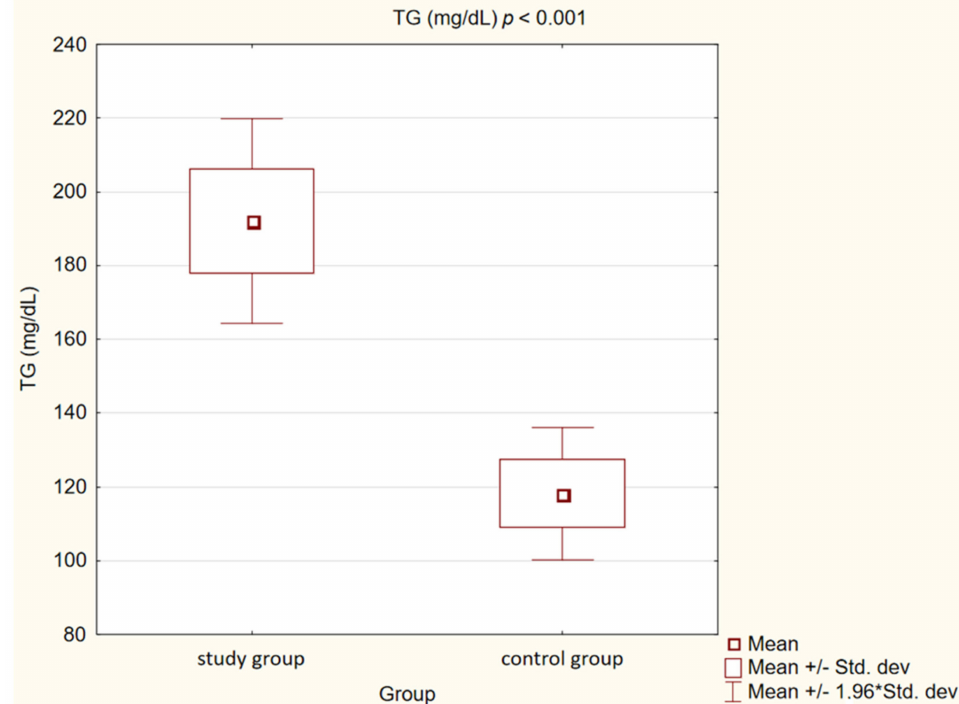
Figure 3. Concentration of triglycerides (TG) in study and control group.